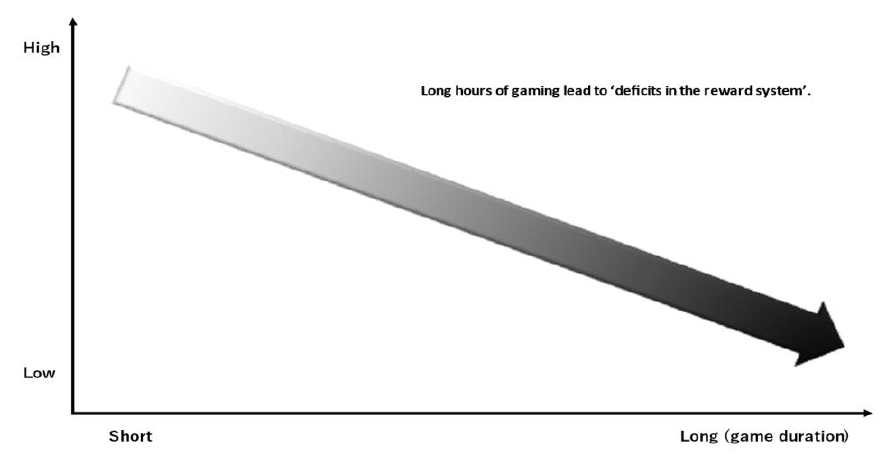
Figure 5. The reward system and the prefrontal cortex (level of satisfaction/activity of the reward system).